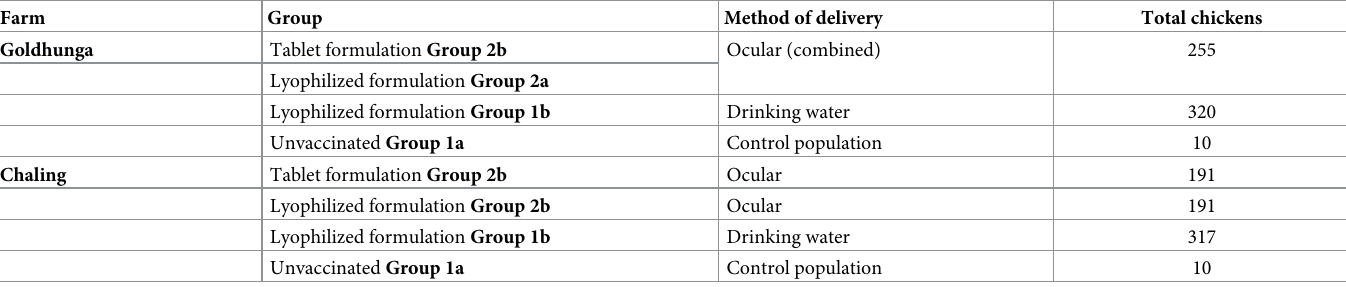
Table 4. Number of birds sampled (with CI 95%) for the post vaccination assessment of live I2- NDV and antibody titer response at the two trial farms (Goldhunga and Chaling).